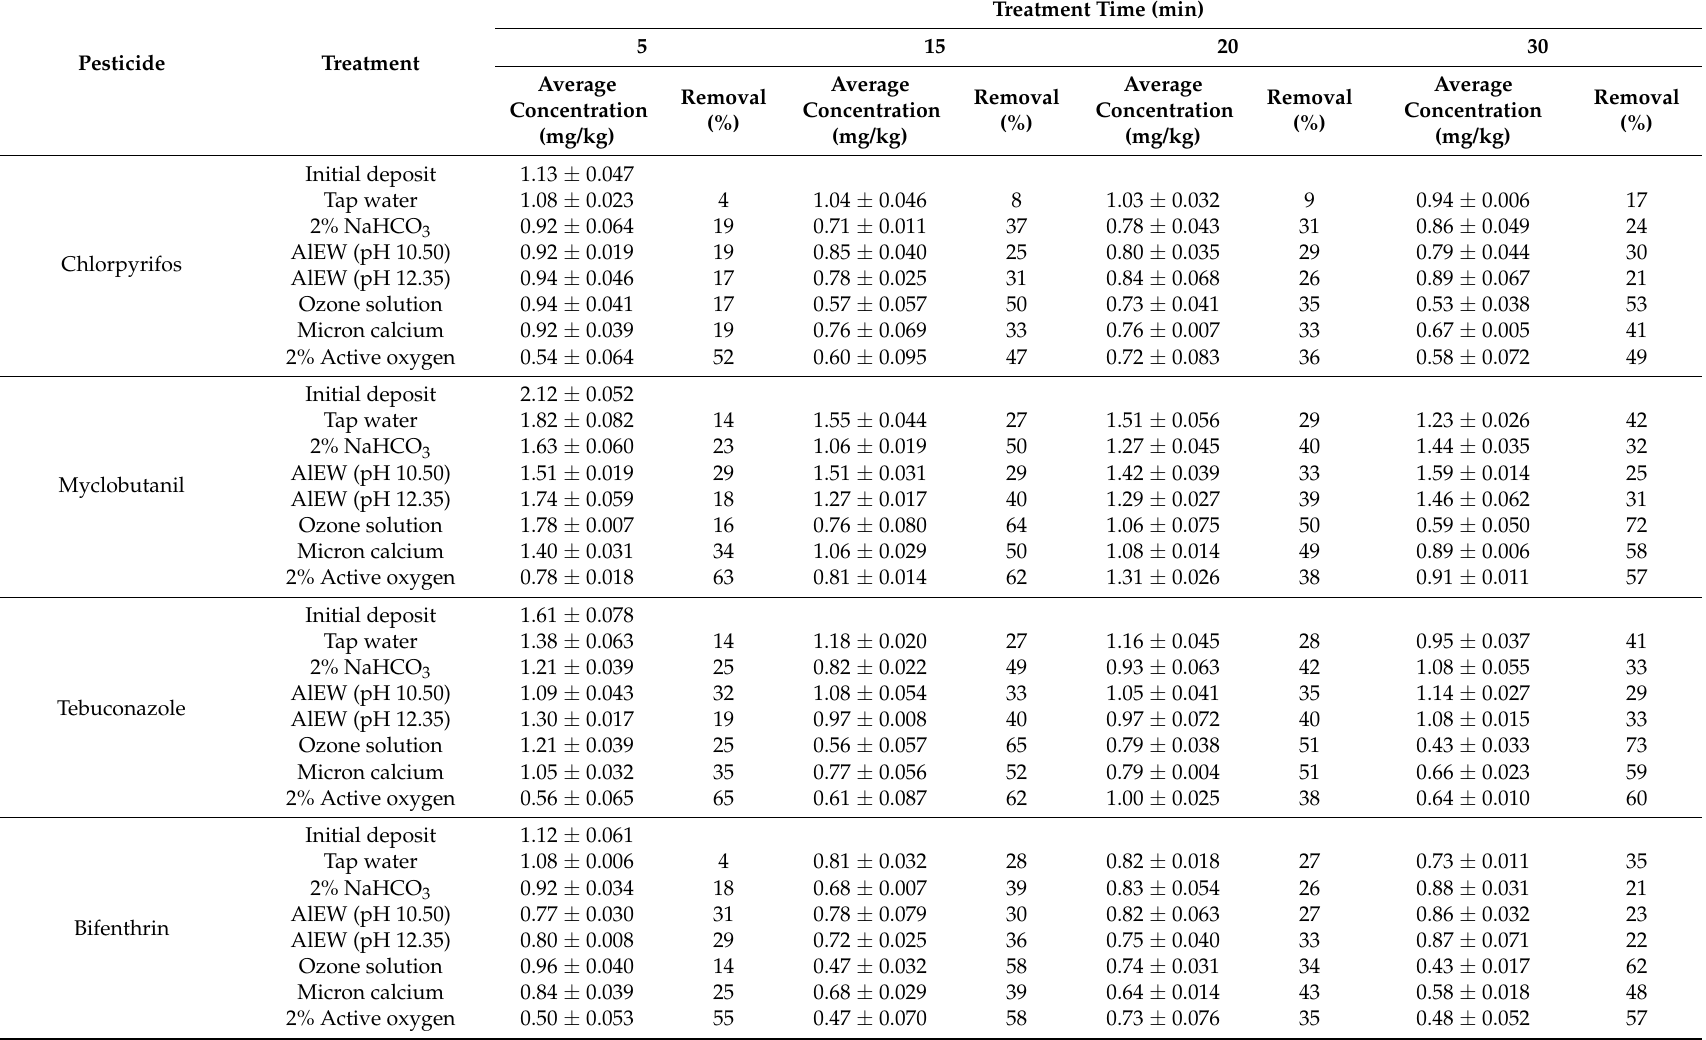
Table 8. Effect of washing treatments for pesticide removal in spinach ( n =